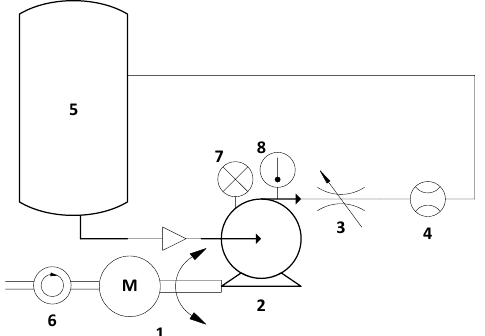
Fig. 6. CP test stand diagram: 1 – electric motor with an inverter, 2 – pump, 3 – throttling valve, 4 – flow meter, 5 – tank, 6 – RPM sensor, 7 – pressure sensor, 8 – temperature sensor Fig. 7. Diagram of the process of mapping the geometry of the working chamber of the CP Citroen